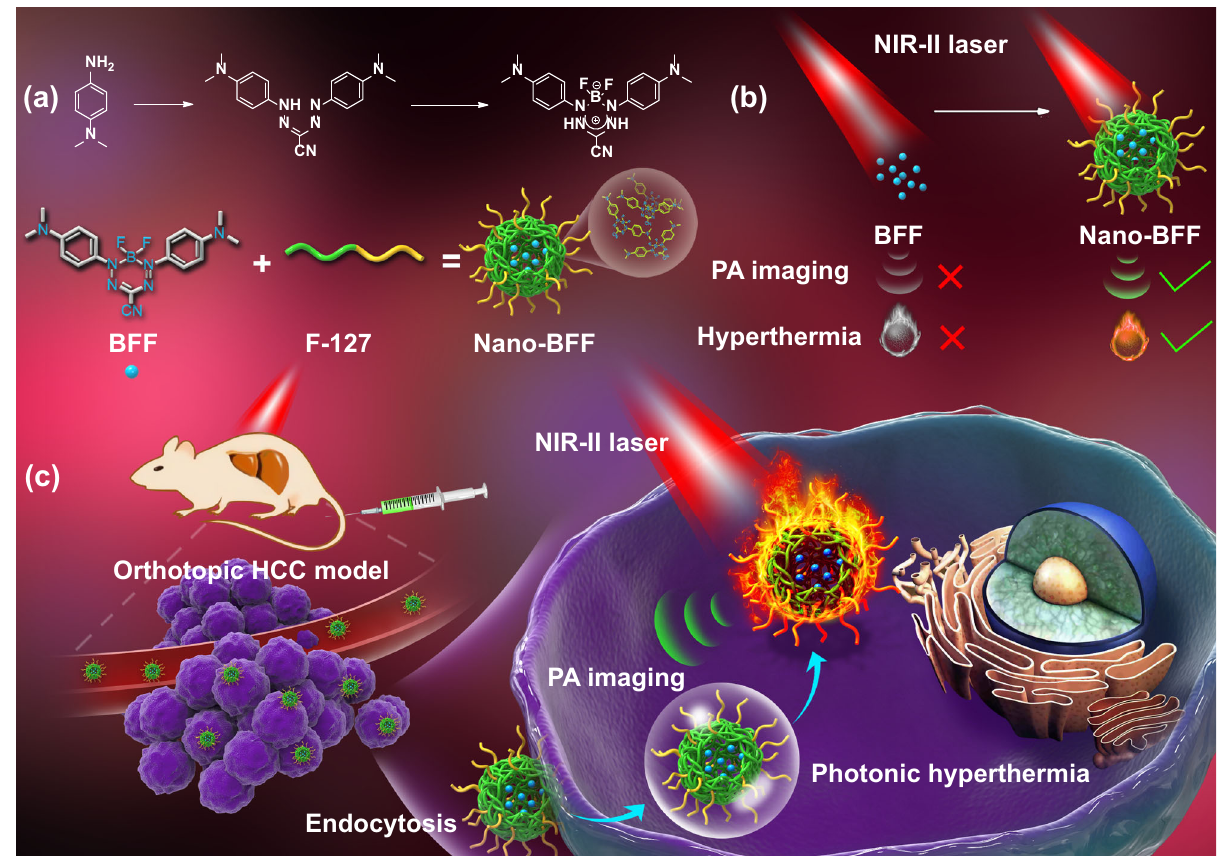
Fig. 1 Schematic construction of Nano-BFF and its theranostic application. a Schematic illustration for self-assembled construction of Nano-BFF. b , c Its speci fi c theranostic application in PA imaging-guided deep-tissue photonic hyperthermia in the NIR-II